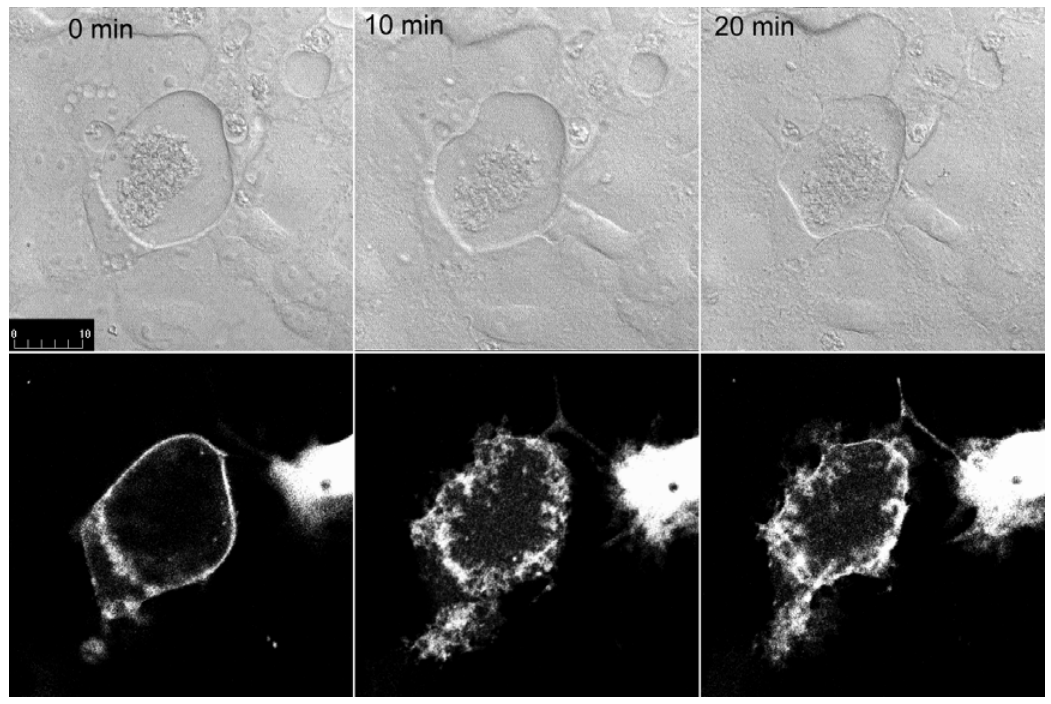
Fig. 5 – Bafilomycin A1 induces dispersion of EGFP-LAMP1-labeled C. burnetti vacuoles. Sequential series of DIC images with the corresponding fluorescence in cells treated with Baf 1A. Bar in µ